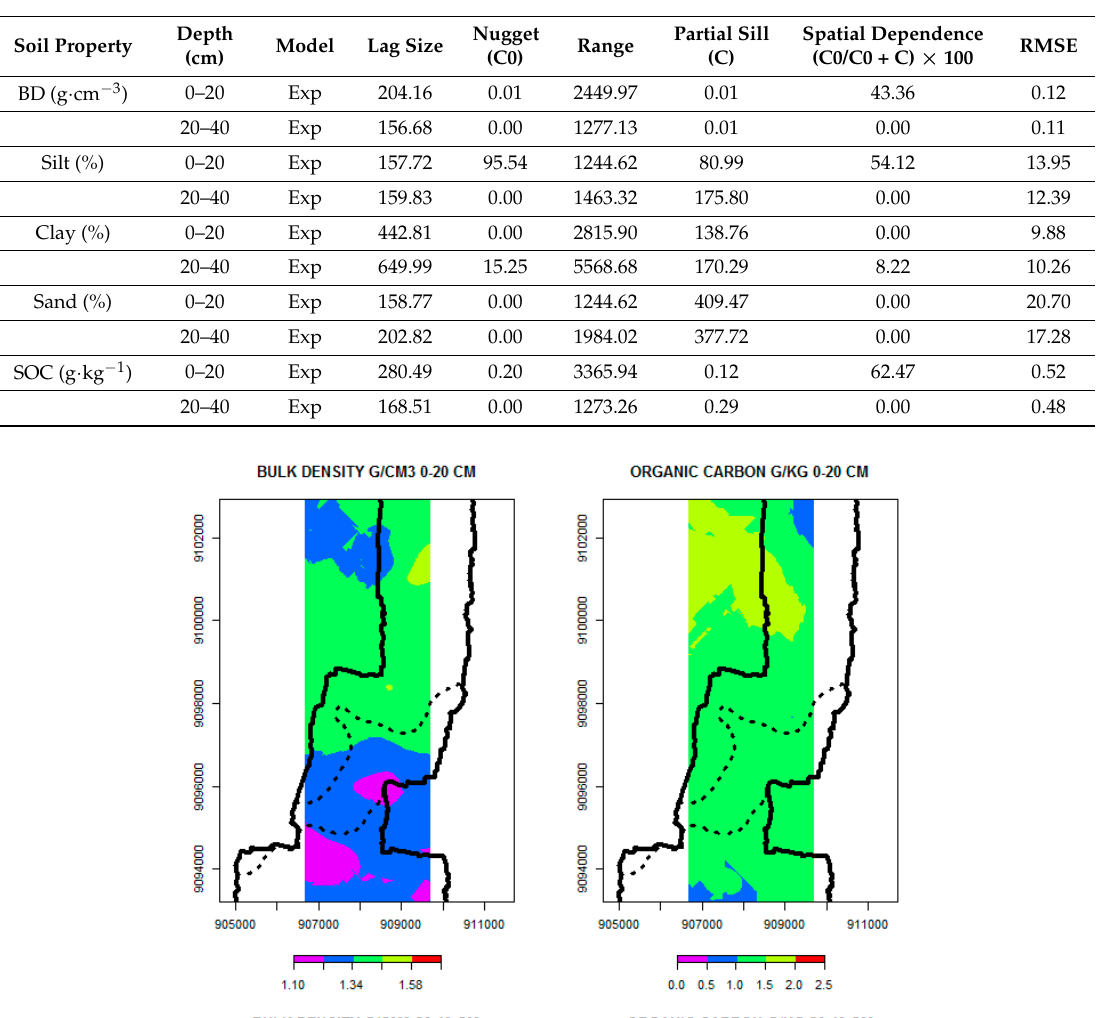
Table 3. Summary of model parameters fitted through the semi-variograms for all sample points in the floodplain.